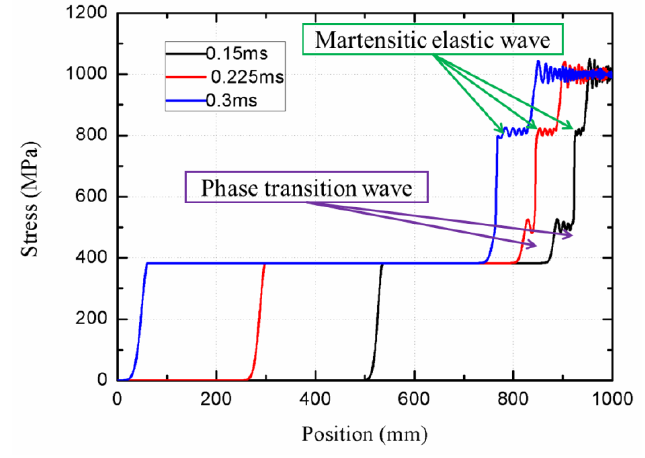
Figure 10. The degeneration of wave structure simulated by MPM.